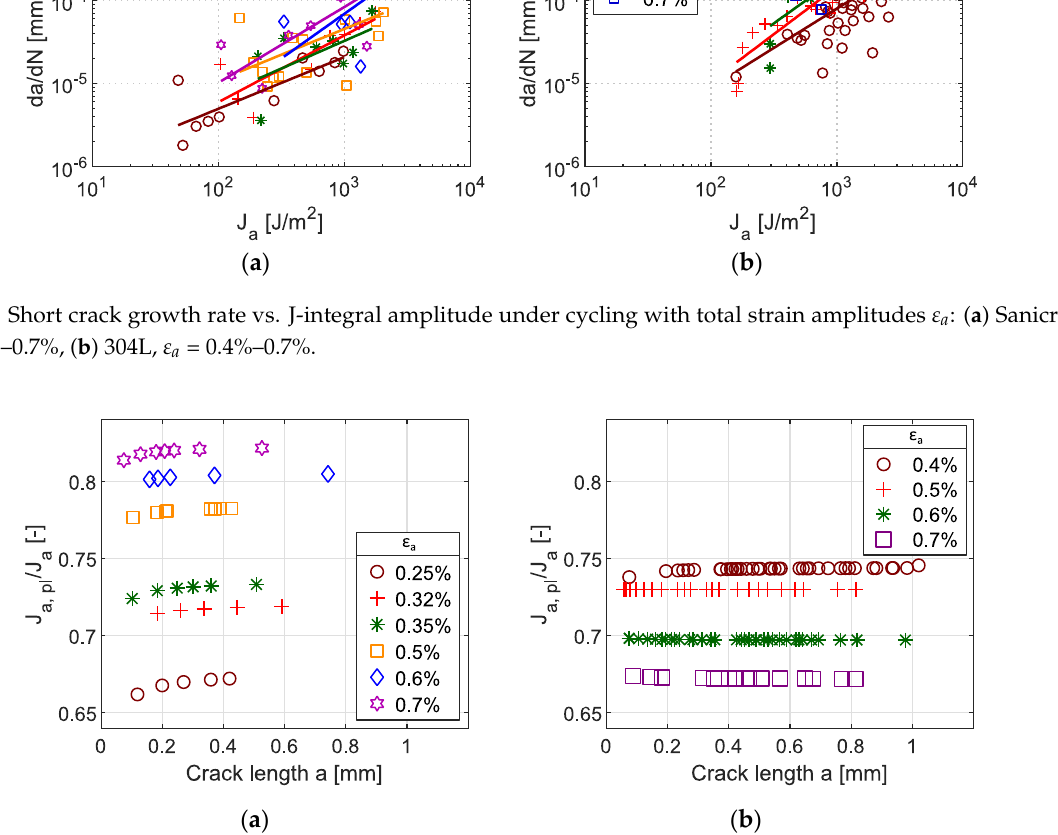
Figure 15. Short crack growth rate vs. J-integral amplitude under cycling with total strain amplitudes ε a : ( a ) Sanicro 25, ε a = 0.25%–0.7%, ( b ) 304L, ε a = 0.4%–0.7%.